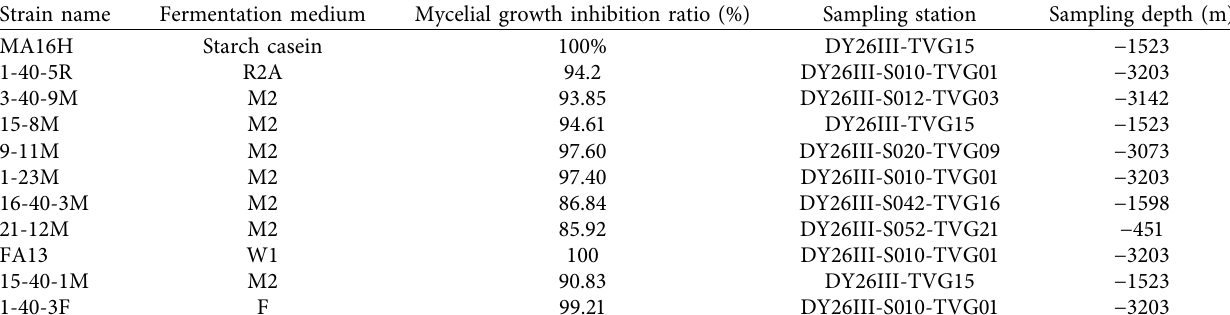
Table 4: Fermentation medium, mycelial growth inhibition ratio, sampling station, and sampling depth for each strain. Strain